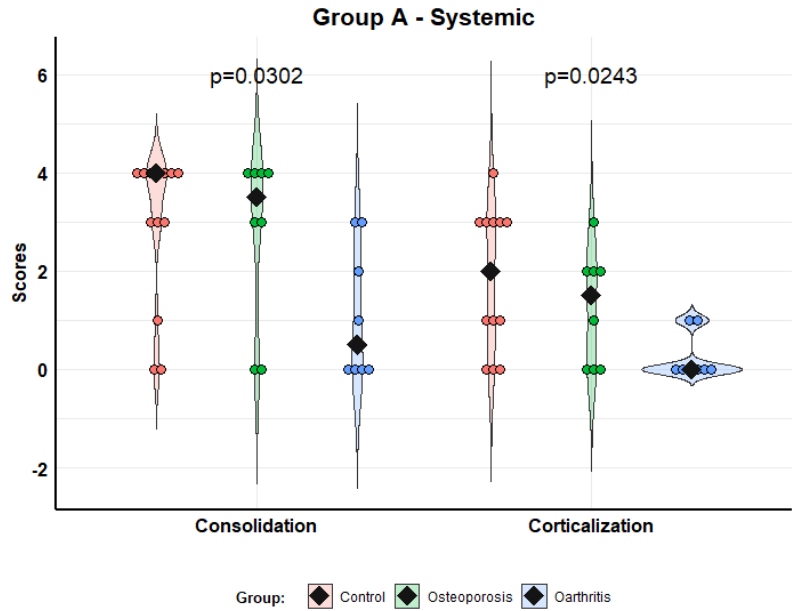
Figure 3. Scores of consolidation and corticalization in model A (systemic administration). Violin plots with individual values and medians (rhombi).